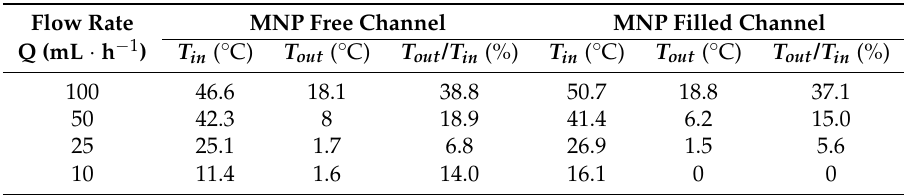
Table 2. Thermal measurement results with the channel. The table shows the measured inlet and outlet temperatures and their ratio at the different flow rates in the MNP-free and the MNP-filled cases. The accuracy of the K-type thermocouple was ± 0.5 ◦